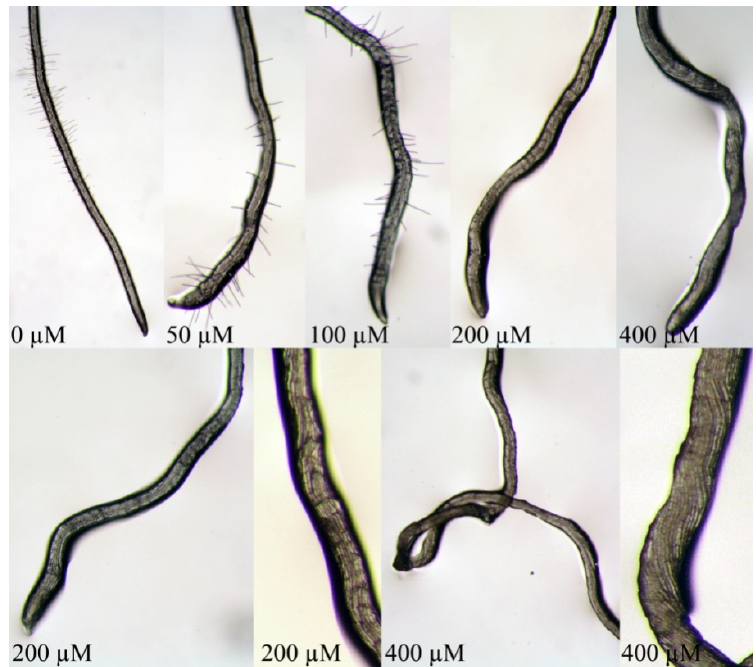
Figure 5. Root tip of A. thaliana grown in vitro and treated with different concentrations of compound 1 . Note the lack of root hairs development at the highest concentrations. NB photos taken with different